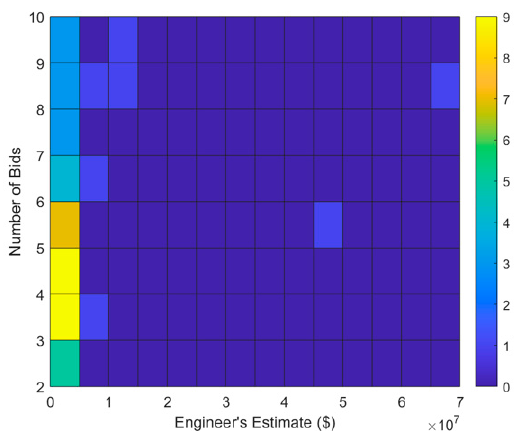
Figure 2. Distribution of the engineer’s estimate per project.